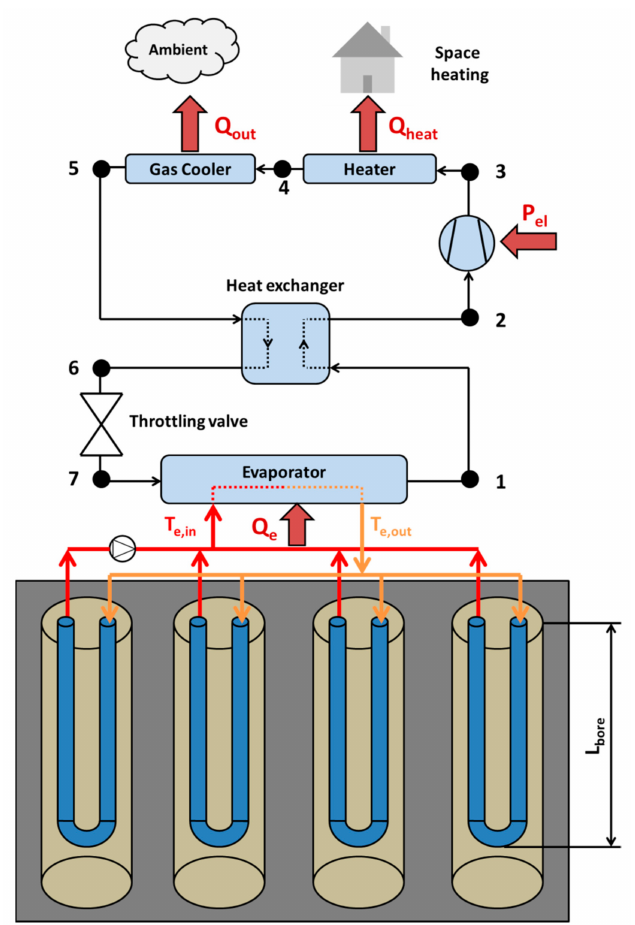
Figure 1. The investigated geothermal-based heat pump. The geothermal field consists of boreholes that feed the evaporator with heat. The number of the boreholes and the borehole length are important parameters that are exam- ined parametrically in the present study. Moreover, the mean temperature of the ground and the thermal conductivity of the grout are examined parametrically in order to study the system in different conditions. The analysis takes into consideration important parameters such as the diameter of the inner tube in the borehole (U-tube), the total thermal